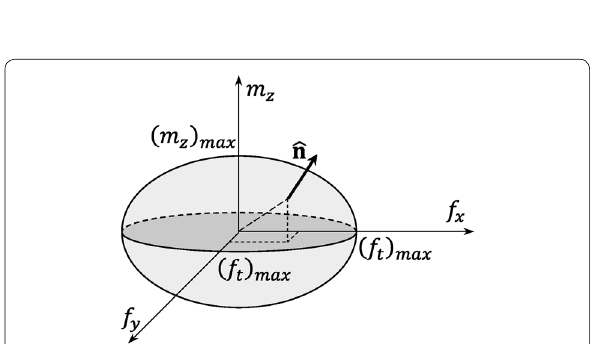
Fig. 4 Ellipsoidal approximation of friction limit